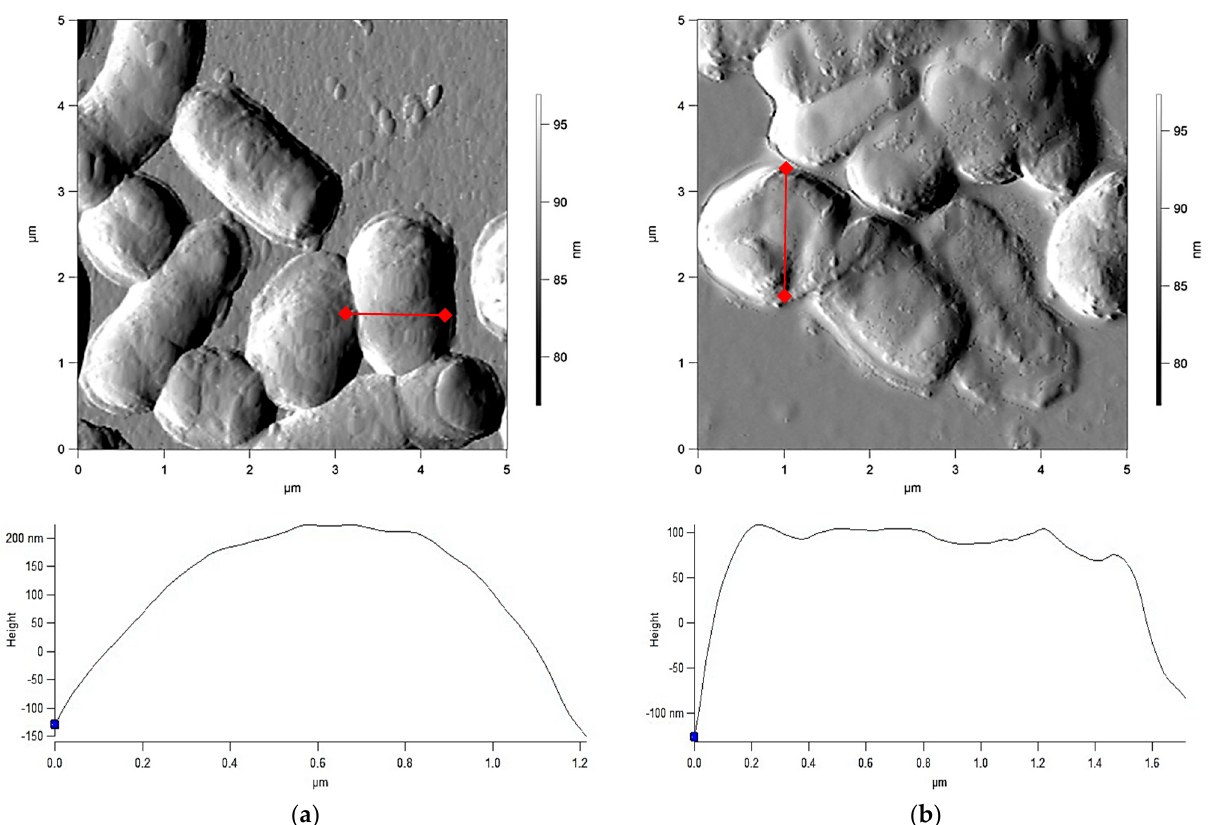
Figure 3. AFM images and profilometry of R. ruber IEGM 1135. Control cells ( a ) and cells exposed to HAuCl 4 ( b ).